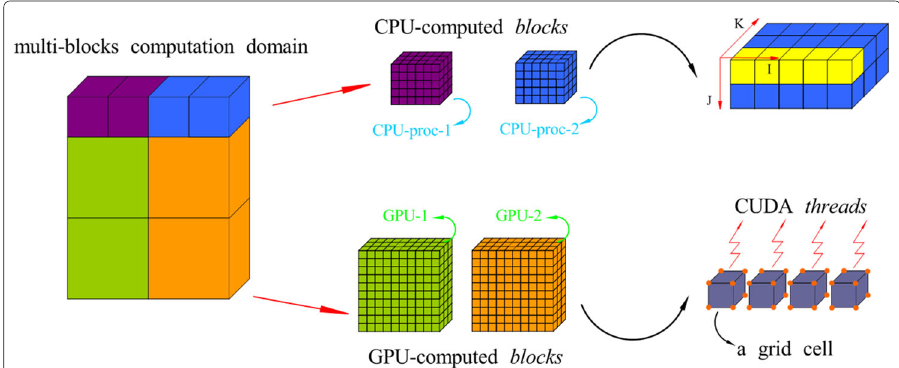
Fig. 5 Domain decomposition strategies of HiResX . The domain is divided into several blocks according to performance of CPU and GPU in order to balance workloads of each process. For the blocks computed by CPU, the whole block is computed by a CPU process. For the blocks computed by GPU, each grid cell is computed by one CUDA thread